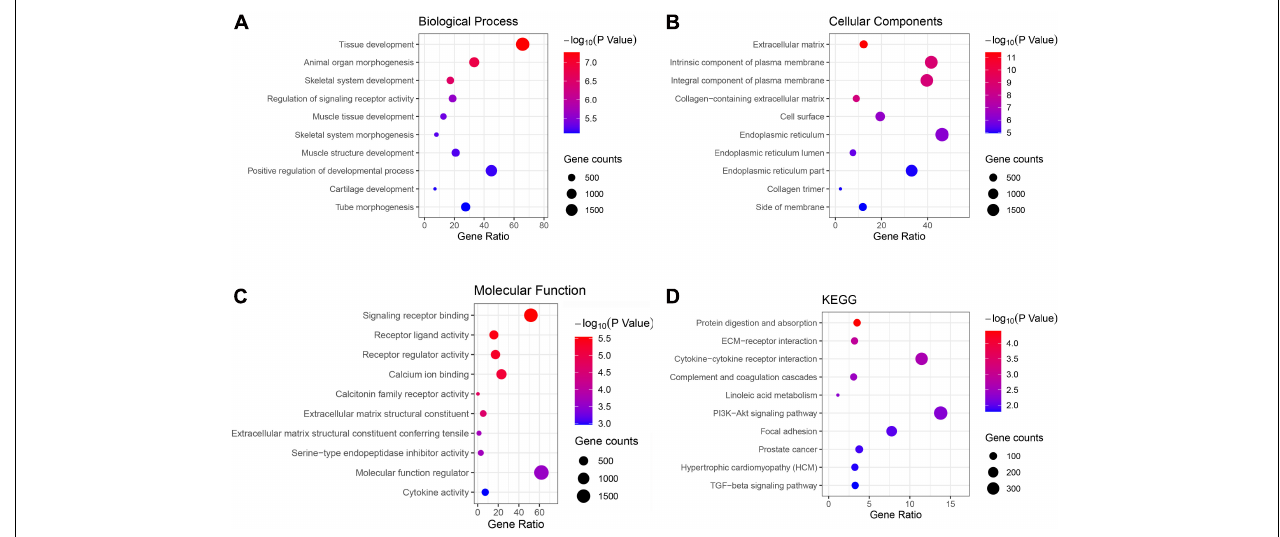
FIGURE 4 | Gene Ontology (GO) terms in (A) biological process, (B) cellular component, (C) molecular function, and (D) the Kyoto Encyclopedia of Genes and Genomes (KEGG) pathway of genes in the green